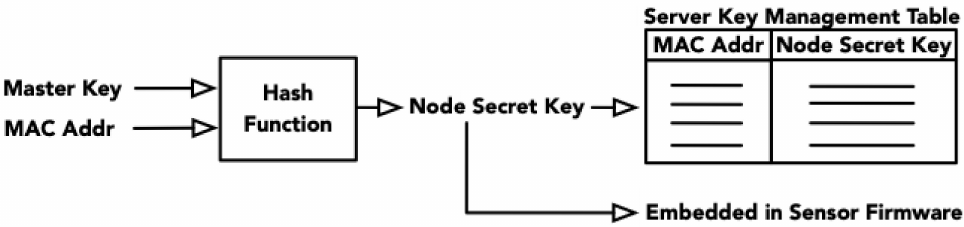
Figure 3. Node secret key